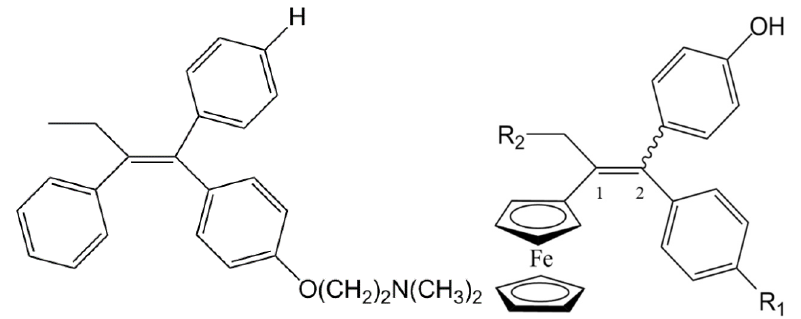
Figure 1. General structure of tamoxifen and ferrocifen compounds.